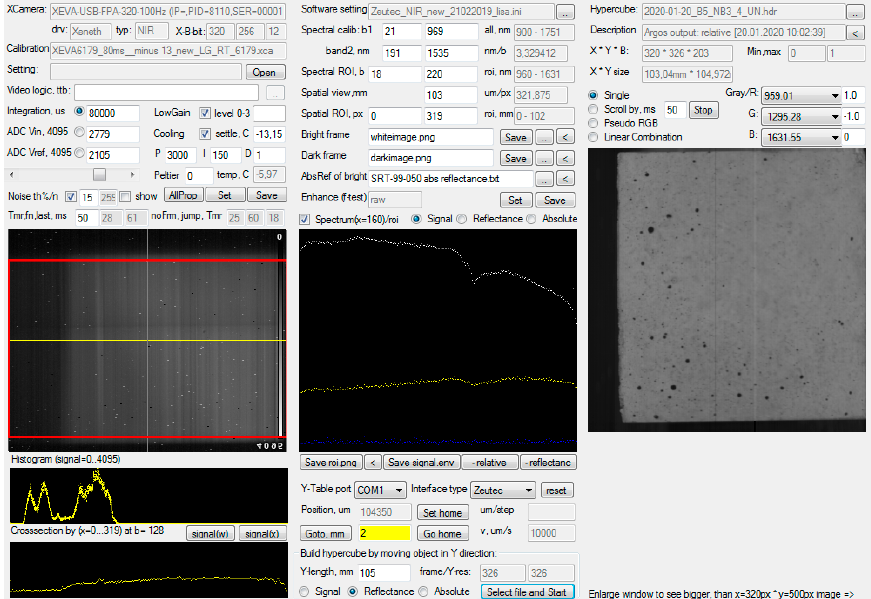
Figure 2. Argus software settings.